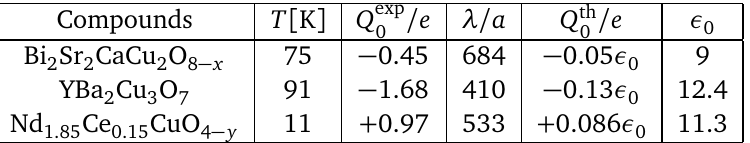
Table 1: Vortex charge coefficients of cuprates. Using Eq. 35, Q exp Hall and magnetoresistivity data at fixed temperature T [ K ] . Q th Q exp